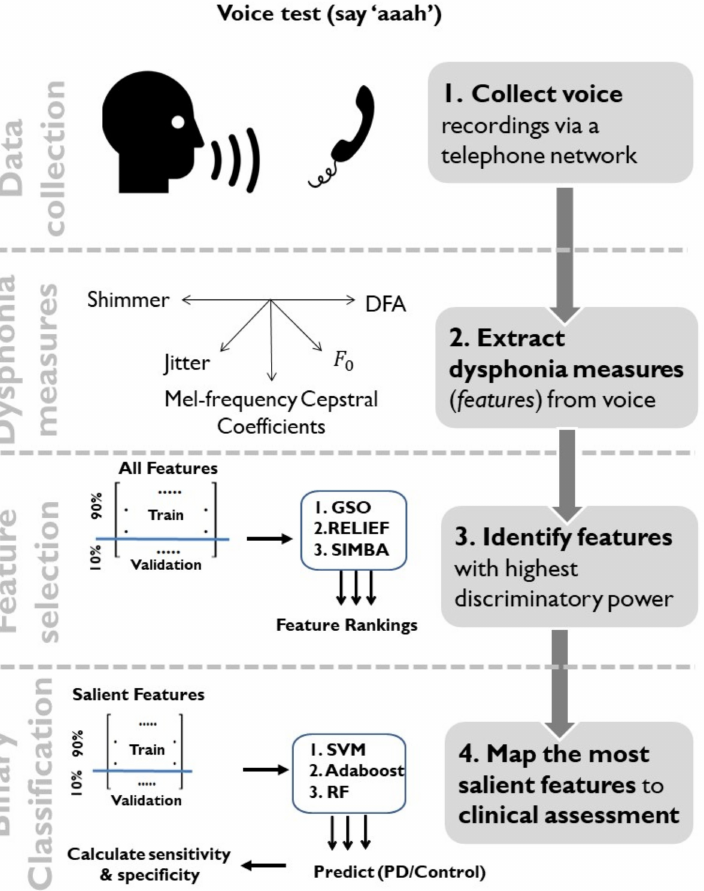
Figure 1. Schematic diagram showing the different stages of this study. Specifically: ( Step 1 ) data collection: sustained phonations were collected over a standard telephone line network; ( Step 2 ) feature extraction: 304 dysphonia measures were extracted from each phonation to characterize voice impairment; ( Step 3 ) feature selection: using a balanced dataset ( n = 1500 PwP and 1500 control participants), the feature matrix was split into non-overlapping training and test data using a 10-fold cross-validation scheme and three feature selection techniques (GSO, RELIEF, and SIMBA) were employed for identifying the most salient features on the training data; ( Step 4 ) classification: the most salient subset of features were mapped onto clinical assessment (PD/Control) using binary classifiers (SVMs, Adaboost, and Random Forests). The final classification step was on the test data held out as part of the CV; subsequently, once we decided on the final statistical learning model, the trained classifier was also presented with the held-out dataset (8942 samples) as an additional performance assessment